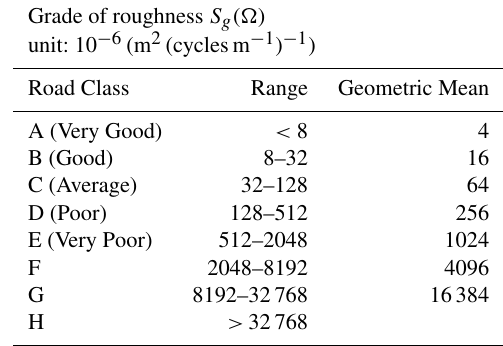
Table 3. ISO road roughness classes. Grade of roughness S g ( (cid:127)